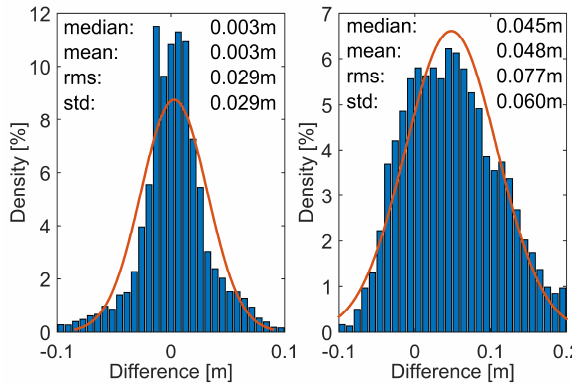
Figure 3. Histogram of elevation differences (ULS DTM minus laser profiler), red line: PDF of the corresponding normal distribution; (a) bare ground; (b) water surface